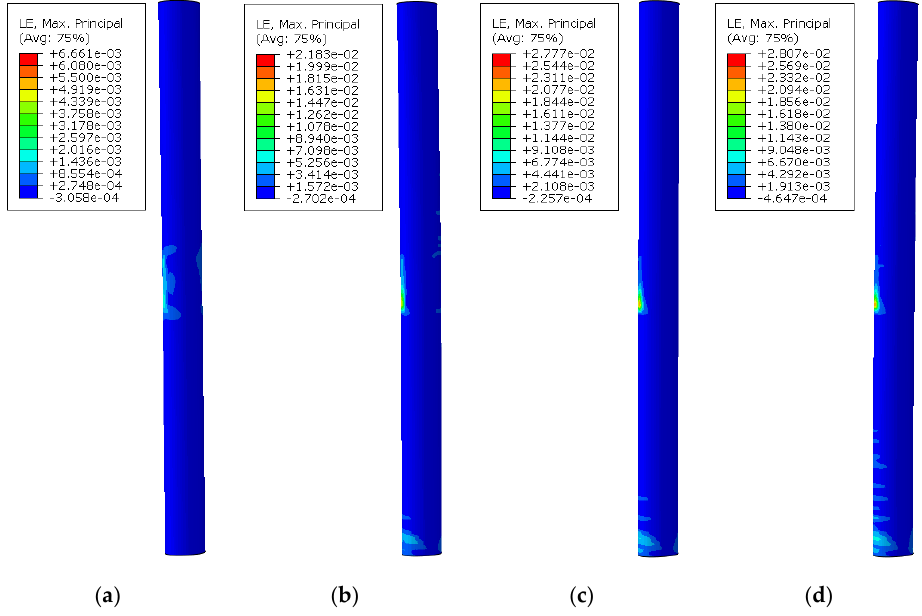
Figure 15. Strains on the core concrete. ( a ) Local response, 0.1 ms; ( b ) Overall response, 1.3 ms; ( c ) Stable response, 5.3 ms; ( d ) Descending response, 7.1 ms.